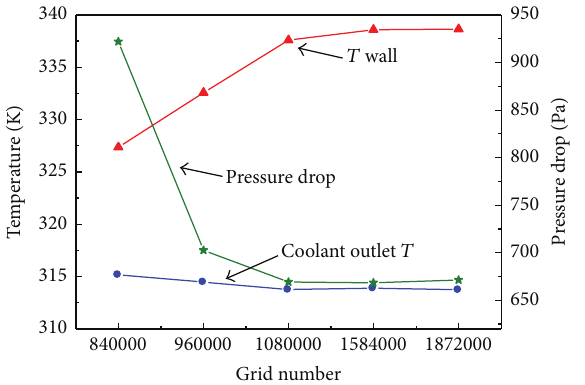
Figure 5: Calculation results of cases with different grid numbers.